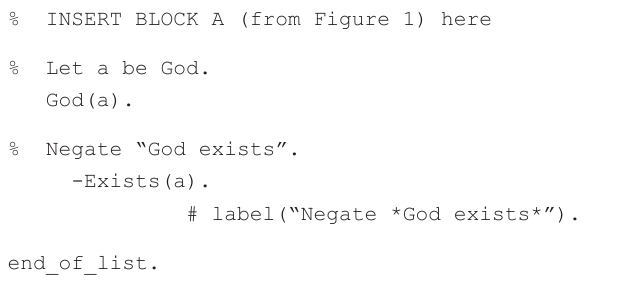
Figure 4: A derivation of (GE) that assumes (SE) and the DAPI. Figure 4 is not literally identical to SFOA, but if we recast it as a proof by contradiction, beginning with the assumption “God does not exist” (negation of (e) in Figure 3), the recasting implies the equivalent of the SFOA. If (SE) can be derived from the DAPI (Spinoza thinks he has shown as much39), the derivation of (GE) shown in Figure 3 would follow from the DAPI